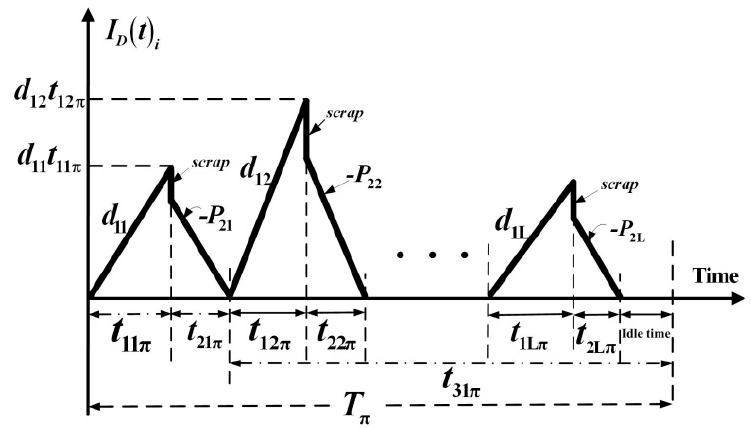
Figure 2. Inventory status of defective products at the manufacturer side of the proposed system.